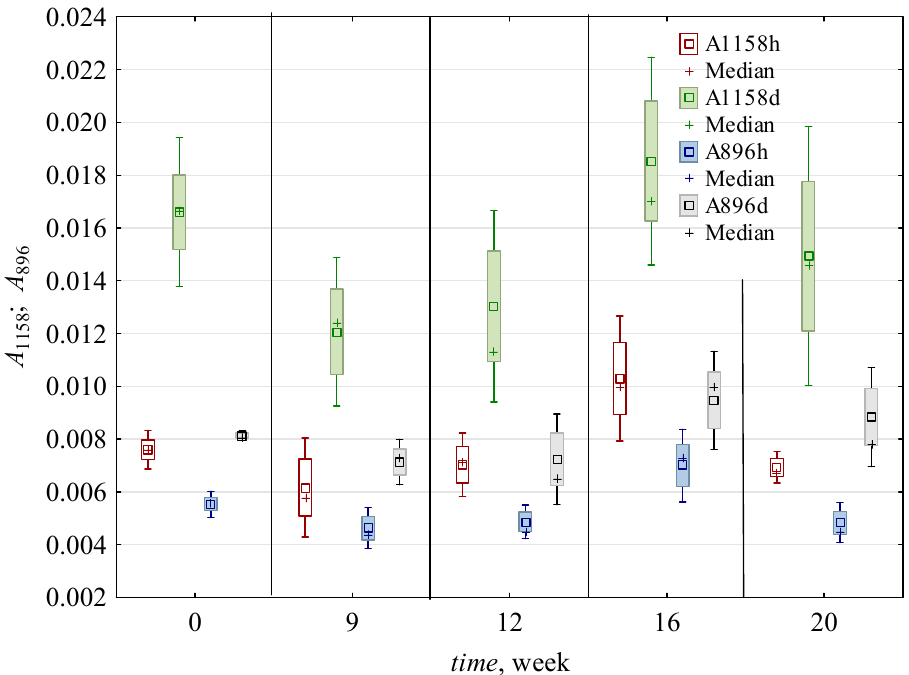
Figure 7. Value of absorbance A 1158 for wavenumber characteristic for C–O–C vibrations in cellulose and hemicelluloses, and for A 896 related to C–H deformation vibrations in cellulose; h —peak height, d —peak deconvolution, □ —mean, frame— SE , and whisker— SD .